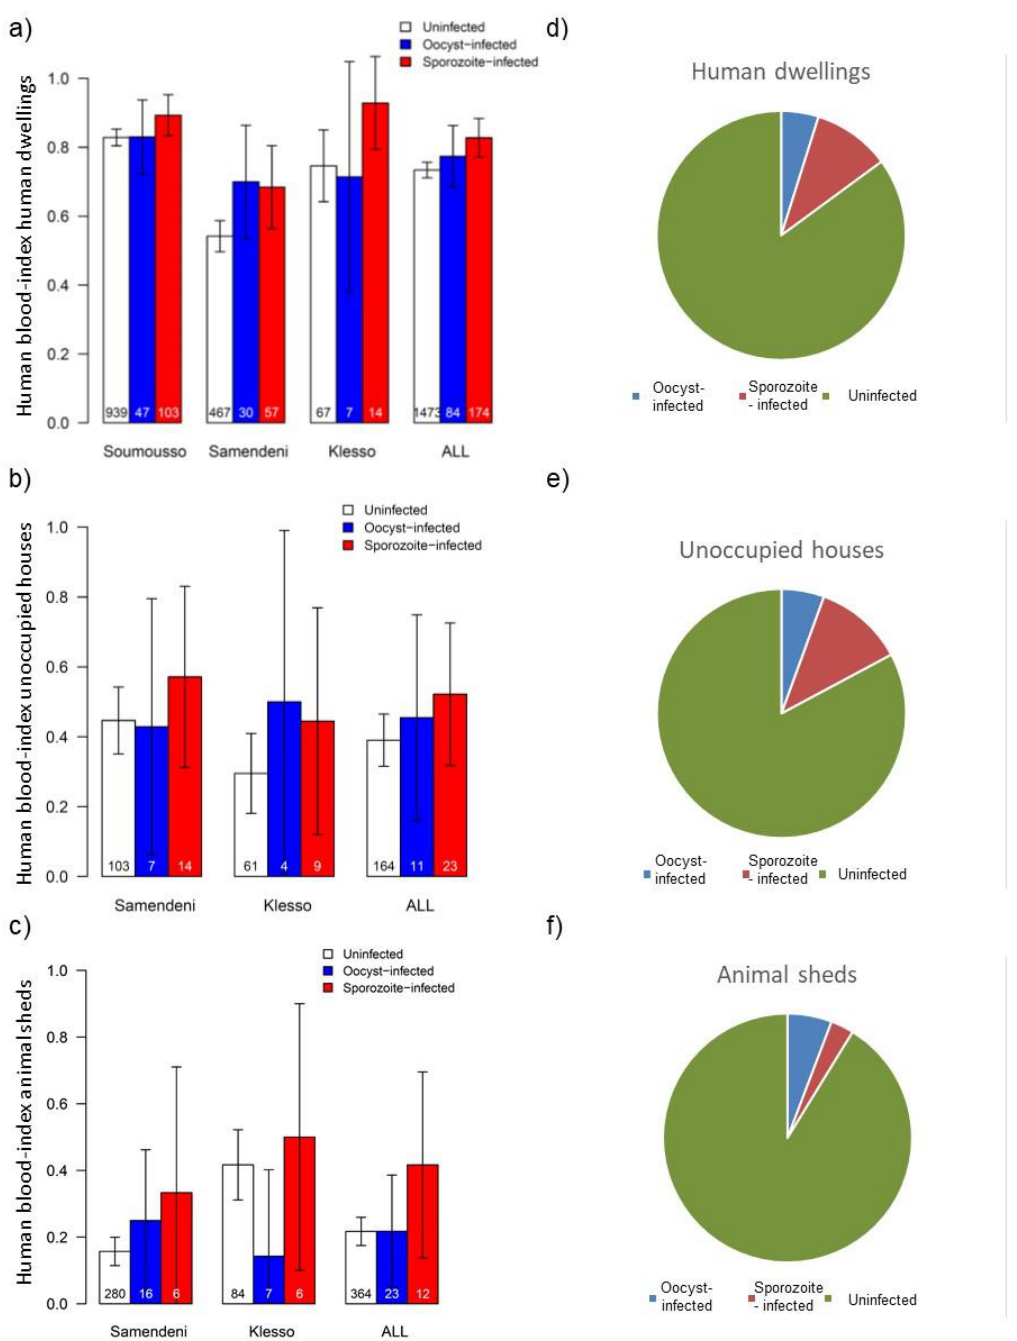
Figure S3. Effect of infection status on the human-blood index of Anopheles gambiae s. l . females expressed as the number of females fed on humans or human-animal mixed blood meals over the total number of blood-fed females in the different village samples in a) human dwellings, b) unoccupied houses and c) animal sheds. Data show proportion ± 95% confidence intervals. Numbers in bars indicate the total numbers of mosquitoes in both traps. Relative proportions of females according to their infection status in d) human dwellings, e) unoccupied houses and f) animal